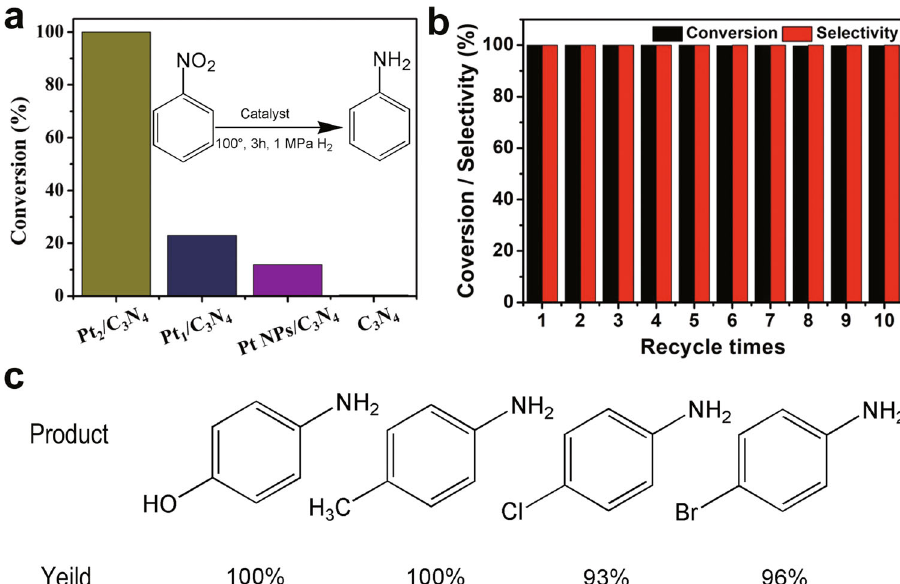
Fig. 3 Hydrogenation of nitrobenzene. a Catalytic performance for the hydrogenation of nitrobenzene by Pt 2 /mpg-C 3 N 4 and other reference samples. b Recycling of Pt 2 /mpg-C 3 N 4 for the catalytic hydrogenation of nitrobenzene. c Hydrogenation of functionalized nitroarenes catalyzed by Pt 2 /mpg-C 3 N 4